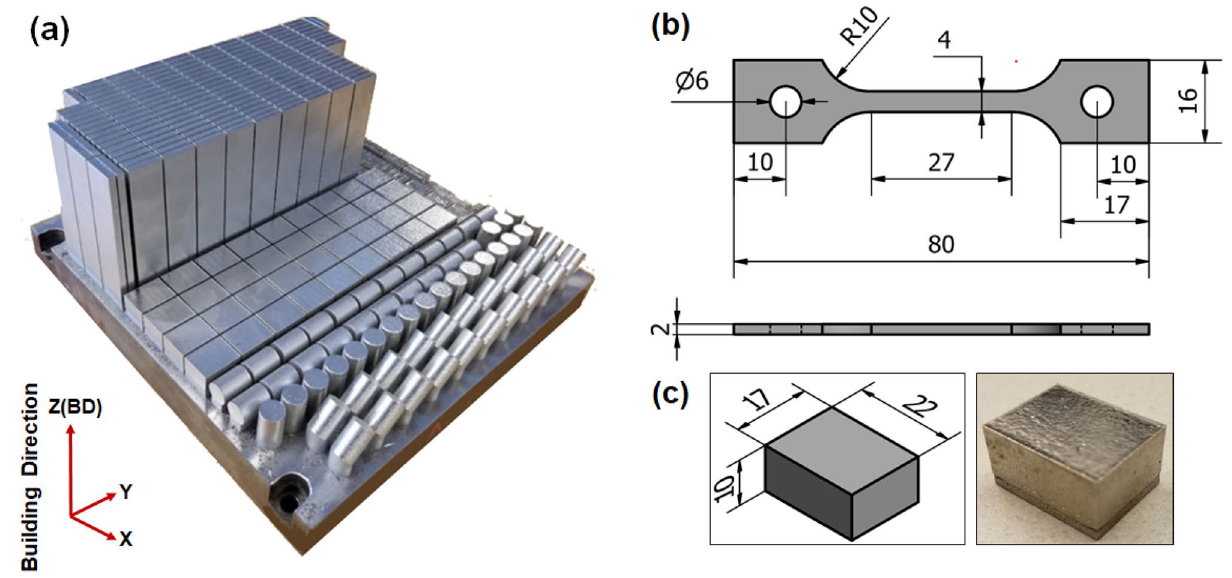
Figure 1. ( a ) Building platform illustrating the building orientation of the prismatic coupons; ( b ) geometry of the tensile samples; ( c ) geometry of the cuboid samples (dimensions in